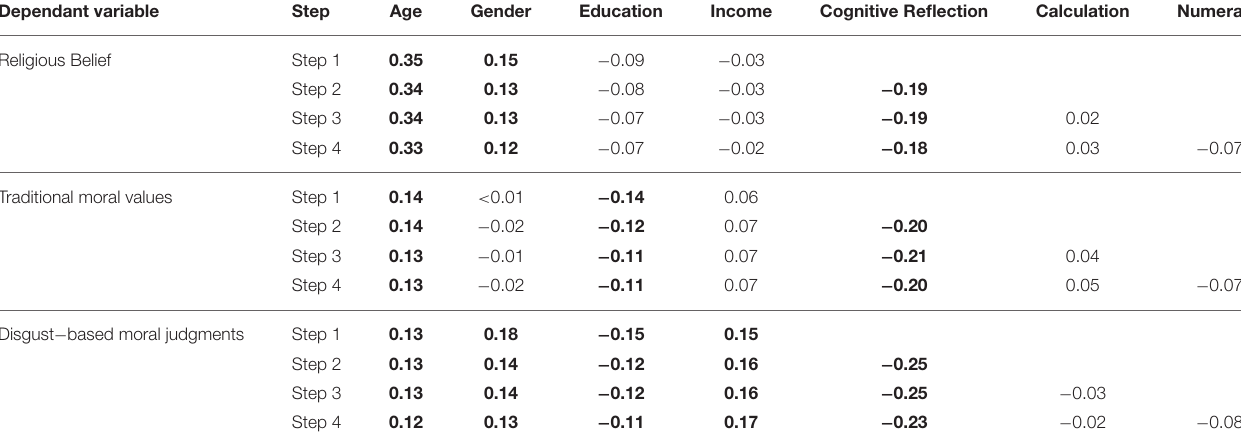
TABLE 1 | Re-analysis of Pennycook et al. (2014). Dependant variable